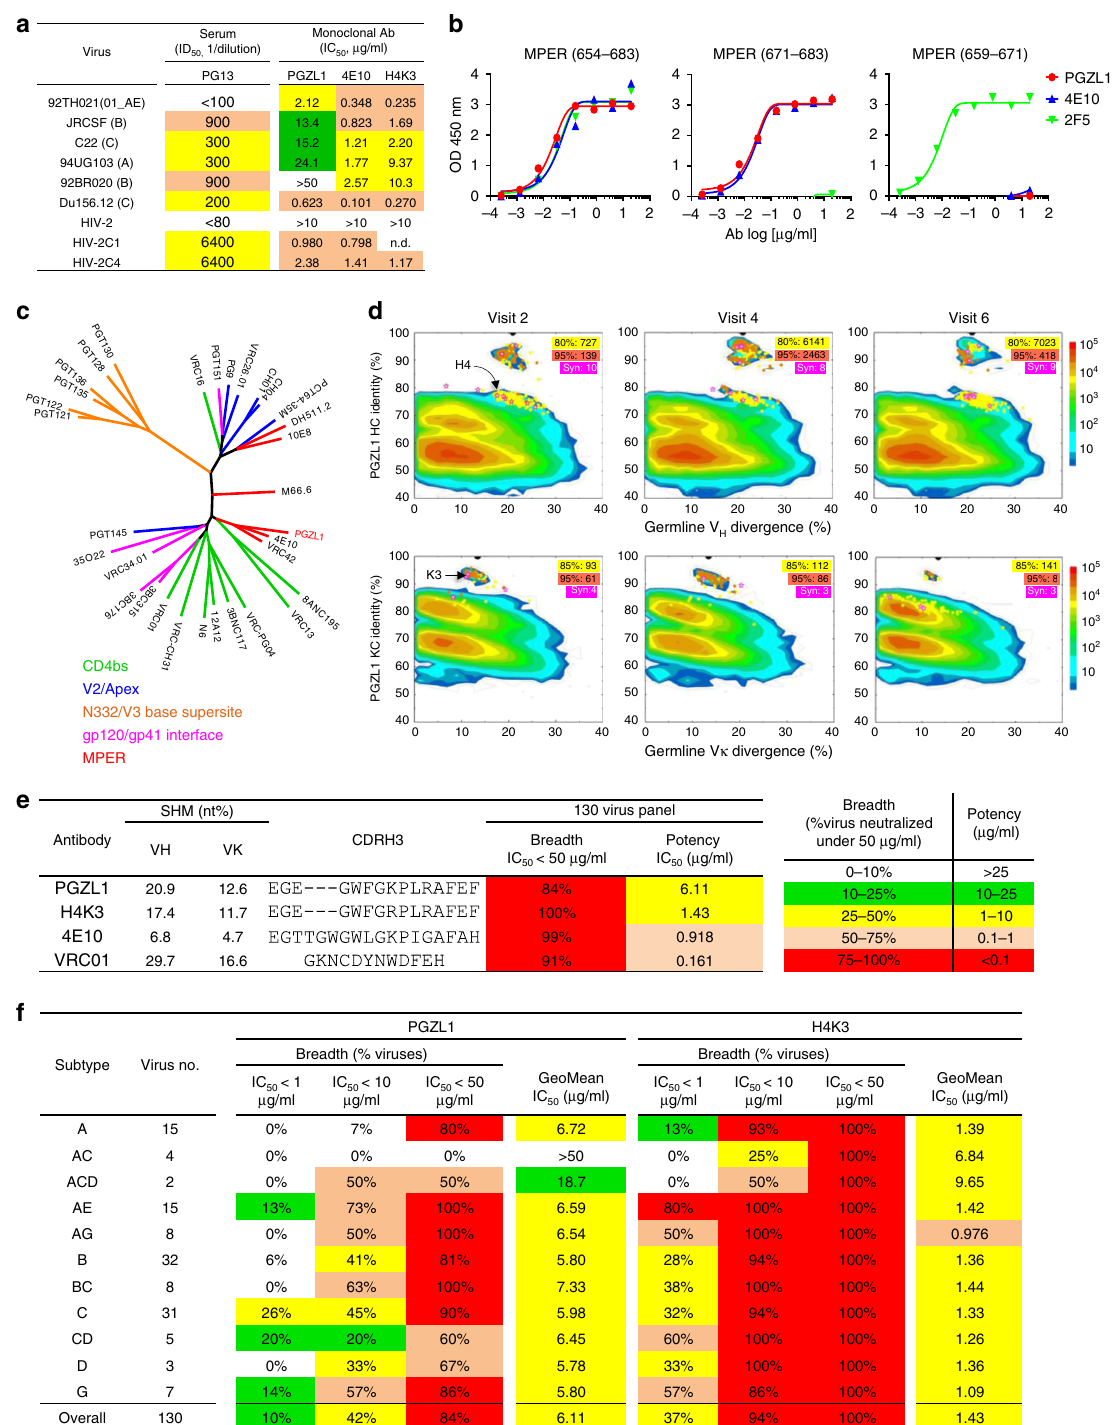
Fig. 1 Properties of an MPER-targeted bnAb . a Neutralization of HIV-1 six-virus panel and HIV-2 (HIV-1 MPER) chimeras by PG13 plasma and monoclonal antibodies PGZL1, 4E10, and H4K3. b ELISA binding of PGZL1 to MPER peptides, using 4E10 and 2F5 as controls. c Maximum likelihood (ML) tree of HC variable regions of described bnAbs, colored by Env speci fi city. d Divergence/identity analysis of donor PG13 antibody repertoire over three visits in 9 months. NGS-derived antibody chains are plotted as a function of sequence identity to PGZL1 and divergence from their putative germline genes. Colors indicate sequence density. Sequences with a CDR3 identity of ≥ 80/85% (HC/KC) and with a CDR3 identity of ≥ 95% are shown as yellow and orange dots on the 2D plots, with the number of sequences highlighted in yellow and orange shades, respectively. Sequences bioinformatically selected for synthesis are shown as magenta stars on the 2D plots, with the number of sequences (Syn) highlighted in magenta shade. e , f Neutralization breadth and potency of PGZL1 and H4K3 against a 130-virus panel ( e ) and the same data as in e but subdivided by HIV subtype ( f ).